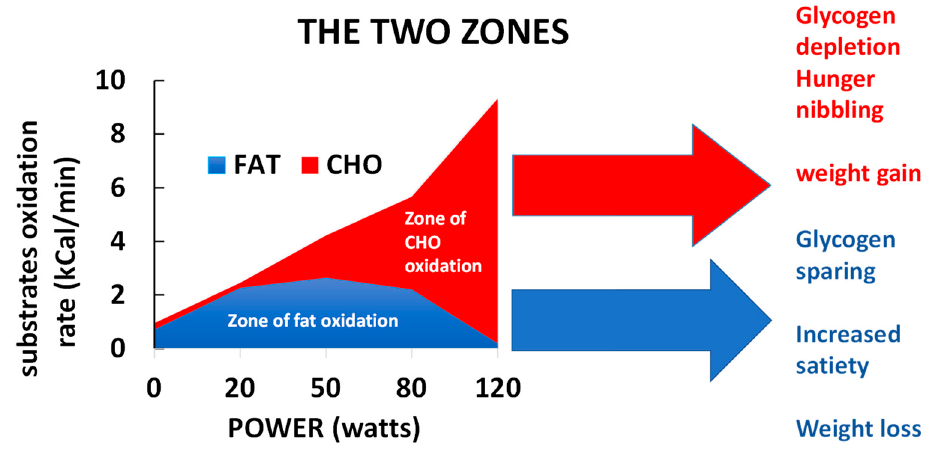
Figure 8. An example of exercise calorimetry in a patient exhibiting a markedly ‘biphasic’ profile of substrate oxidation during exercise. Opposite effects on eating behavior of the two zones of the balance of substrates may, in part, explain why exercise targeted toward fat oxidation induces weight loss [30,344]), while short bouts of exercise targeted toward higher intensities in the zone of predominant oxidation of CHO may induce overeating and paradoxical weight gain [345].